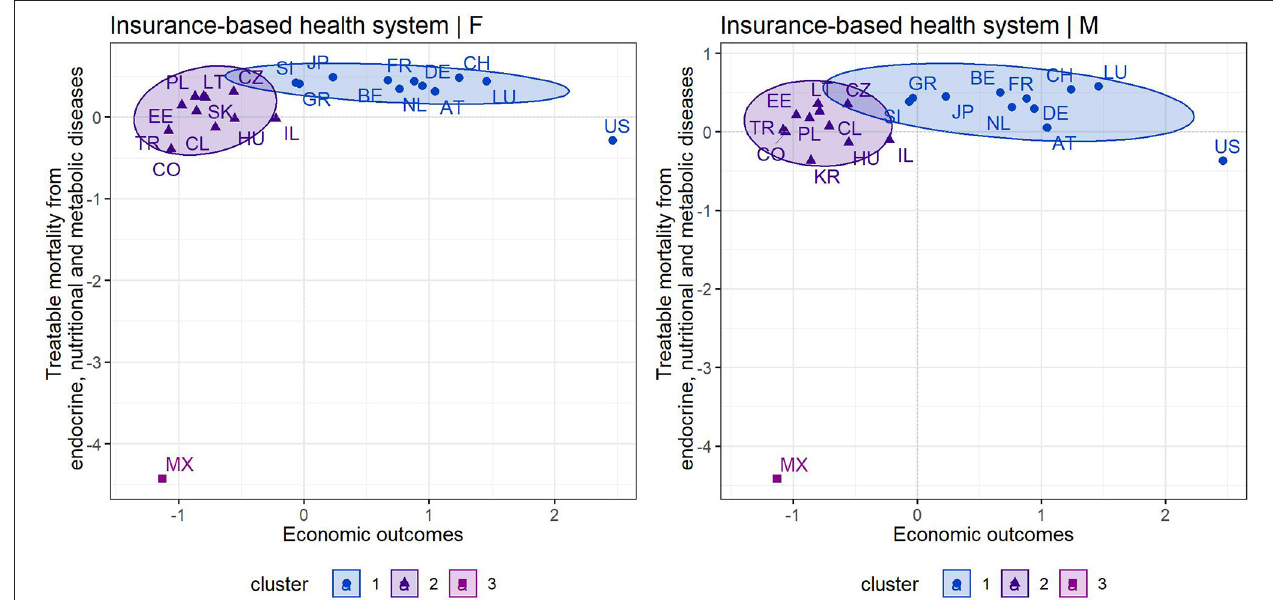
FIGURE 4 | Cluster map—economic outcomes and treatable mortality from endocrine, nutritional and metabolic diseases for countries applying an insurance-based health system—females (F) and males (M).